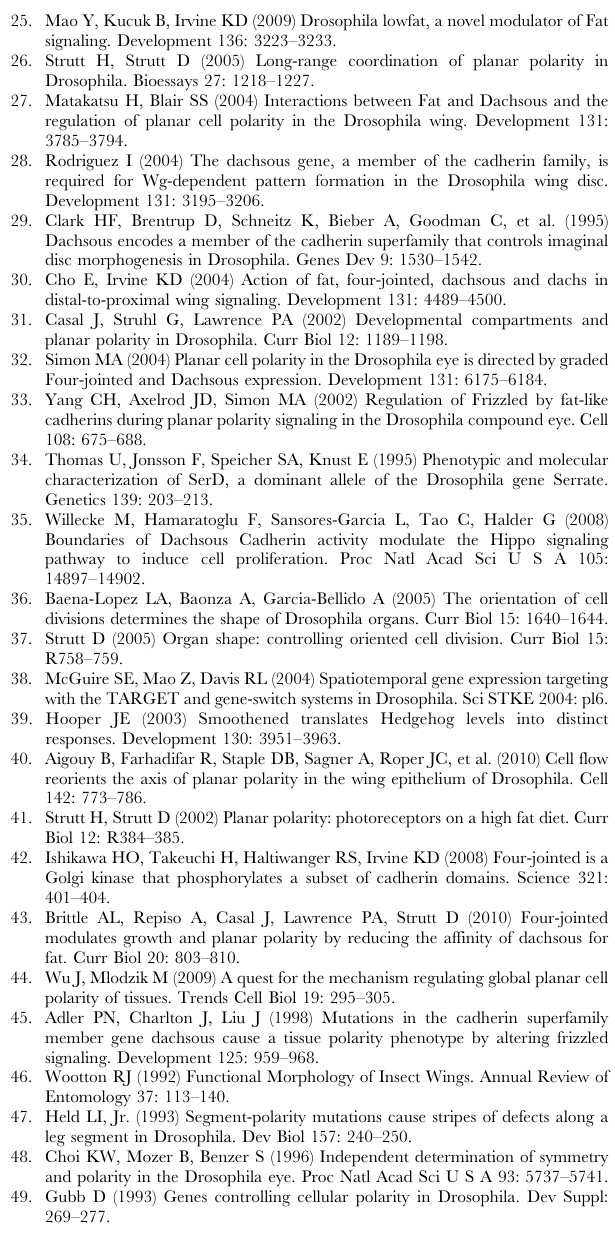
Black arrows indicate local hair polarity. (A) Wing cartoon showing major expression domain of the sal-Gal4 driver (blue shading). (B and C) pk pk-sple-14 homozygote. (D and E) pk pk-sple-14 , sal- Gal4/ pk pk-sple-14 , UAS-ft. (F and G) pk pk-sple-14 , sal-Gal4/ pk pk-sple-14 , ft(IR). (E and F) pk pk-sple-14 , sal-Gal4/ pk pk-sple-14 , UAS-fj. Found at: doi:doi:10.1371/journal.pgen.1001305.s002 (5.17 MB